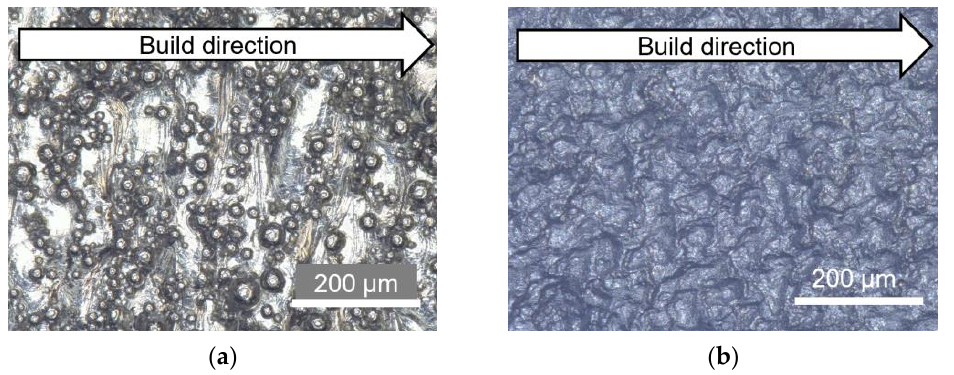
Figure 8. Aspects of specimen surfaces observed by digital microscope: ( a ) as-built specimen; ( b ) specimen treated with laser cavitation.